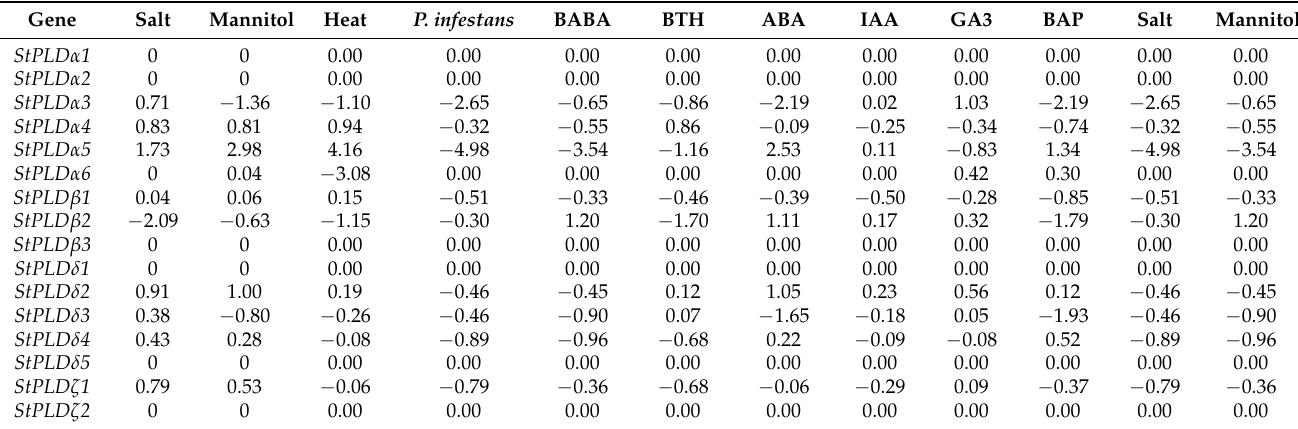
Table A4. FPKM value of auxin transporter gene in various